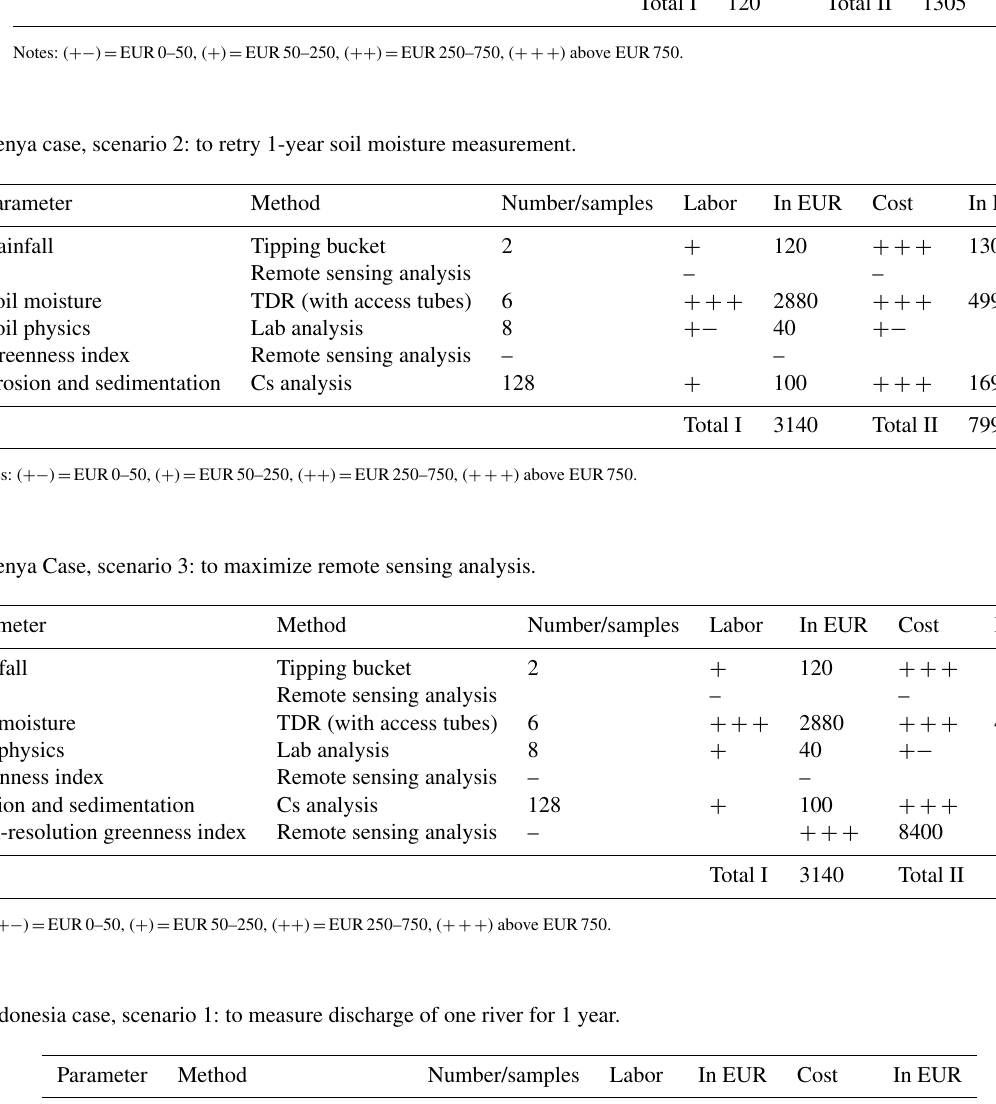
Table A7. Indonesia case, scenario 1: to measure discharge of one river for 1 year.